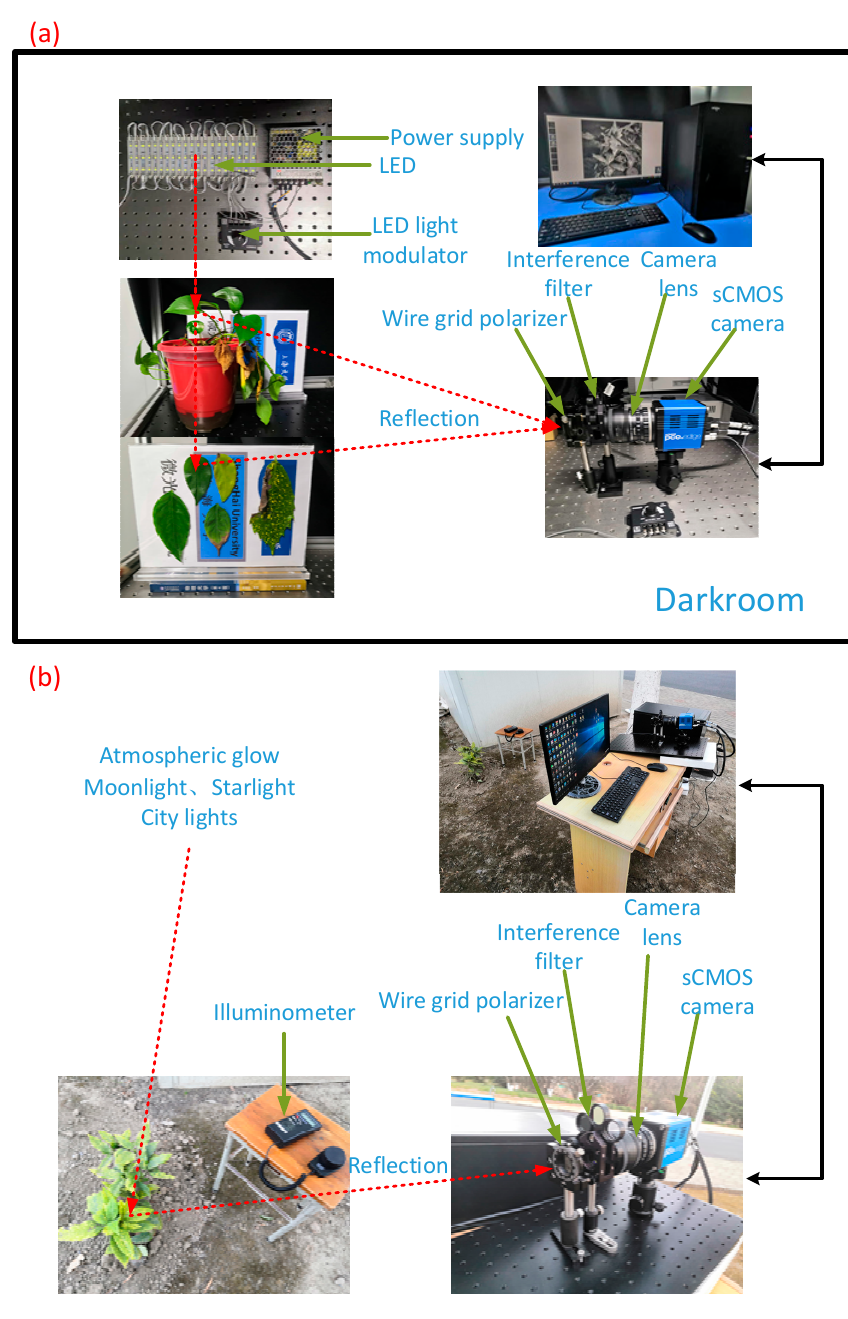
Figure 2. ( a ) Indoor polarized multispectral for a low-illumination-level imaging system. ( b ) Outdoor polarized multispectral for a low-illumination-level imaging system.